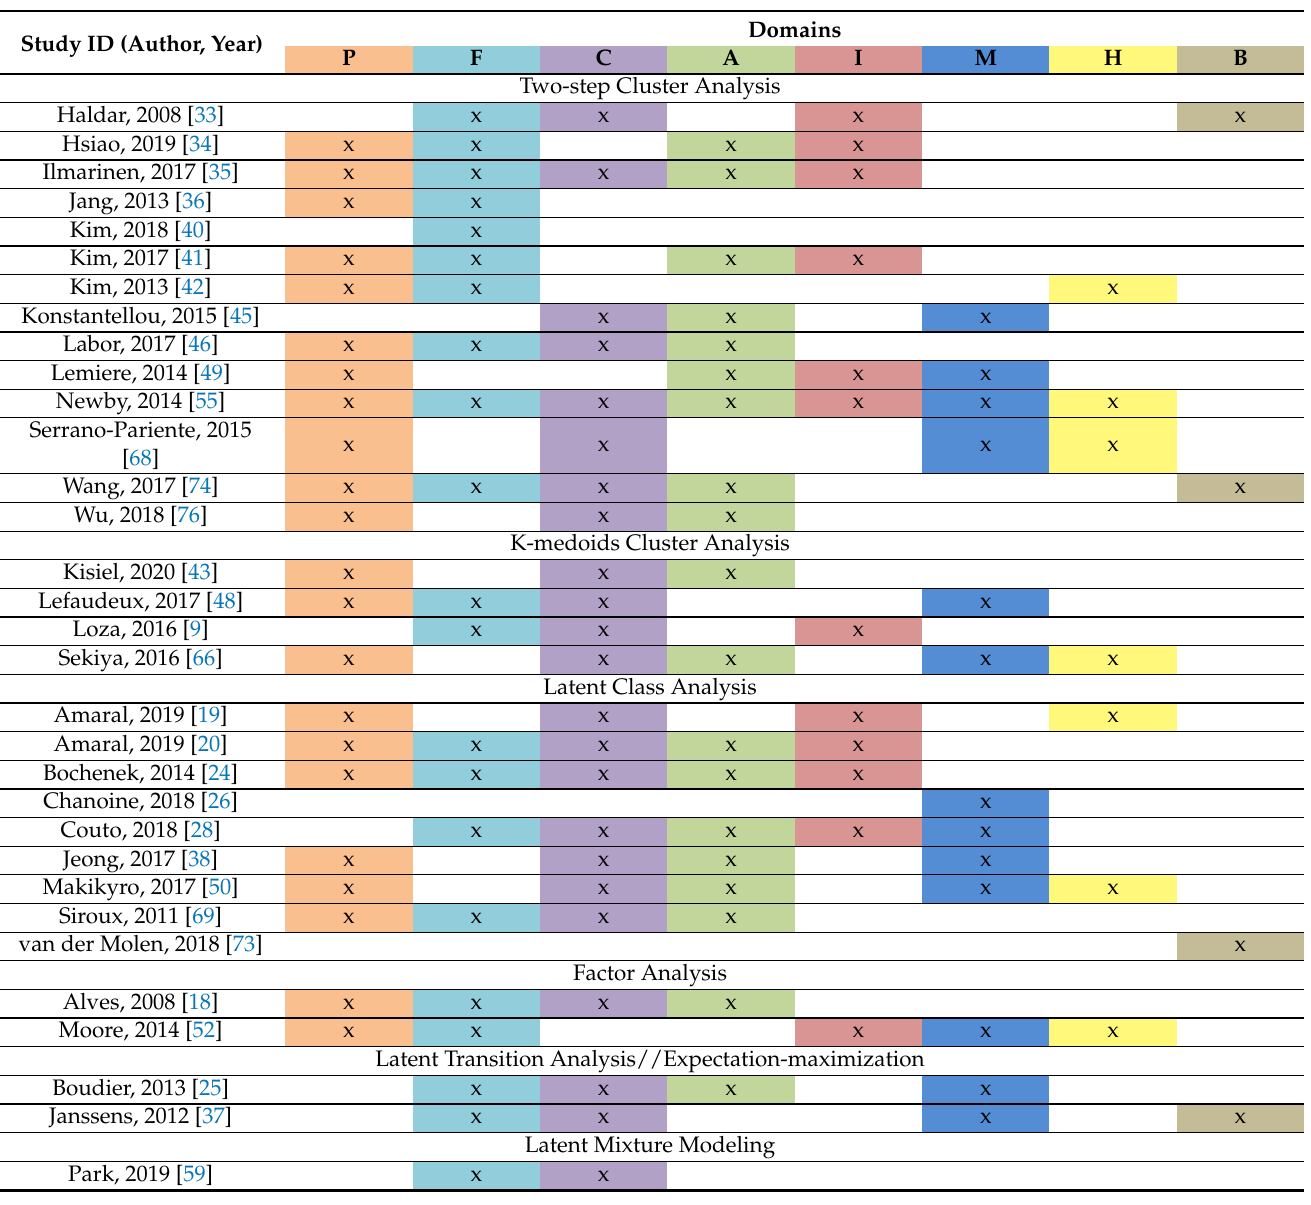
Table A2 summarizes the phenotypes obtained by each study with the respective frequency in the sample. The results are stratified by a data-driven